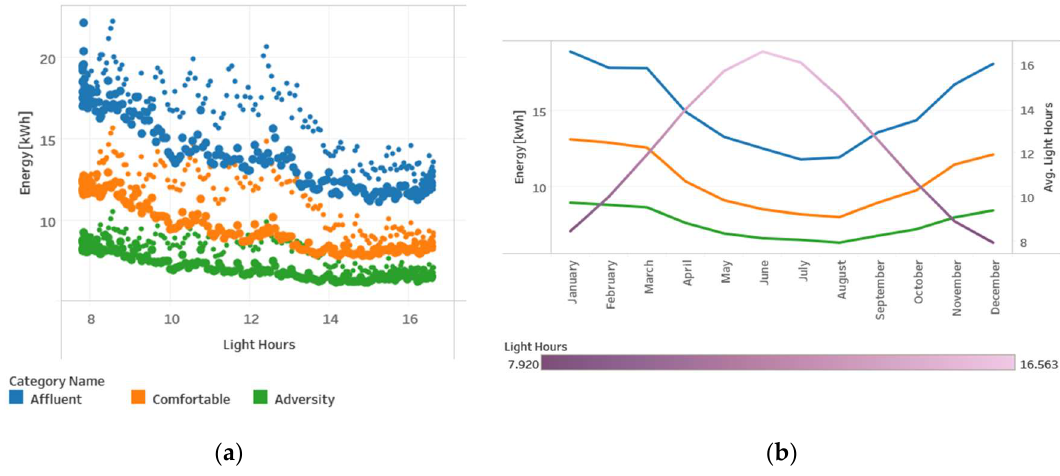
Figure 10. Energy consumption versus light hours per day: ( a ) scatter plot and ( b ) time-line plot.